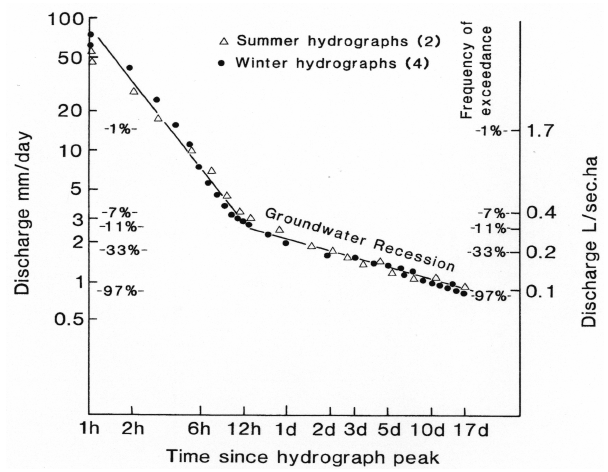
Fig. 2. Master recession curve for Glendhu catchments (from Pearce et al.,